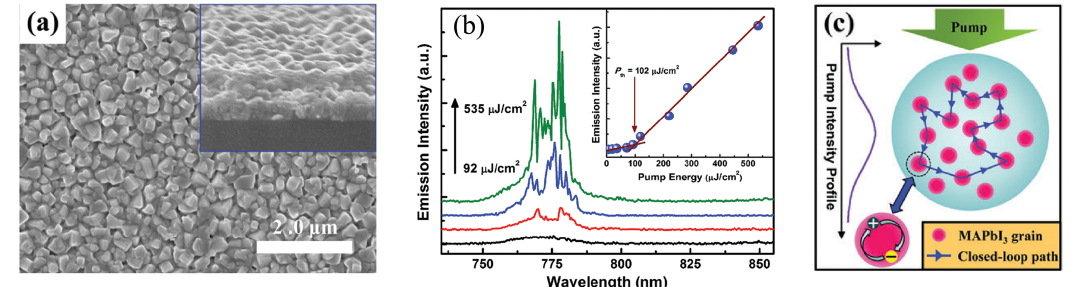
Figure 5. ( a ) SEM image of the CH 3 NH 3 PbI 3 film showing evidence of the presence of cuboids with a typical size of about 200 nm. The inset shows the sample cross section. ( b ) Excitation density dependence of the PL spectra of the film, showing evidence of the progressive appearance of random lasing peaks as the excitation density increases. Inset: excitation density dependence of the PL intensity, showing the random lasing threshold. ( c ) Pictorial view of the formation of a closed-loop laser cavity via random scattering provided by the polycrystalline grain boundary. Adapted with permission from [40]. Royal Chemical Society,